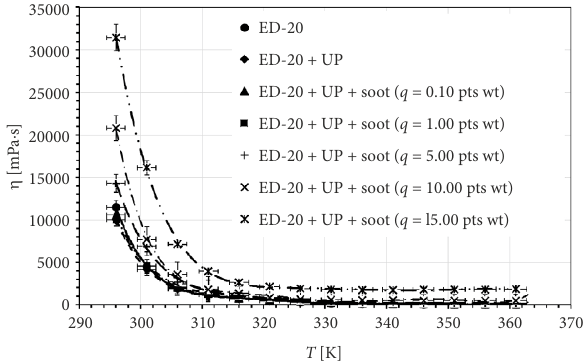
Figure 1. The effect of temperature T on the mean dynamic viscosity η of the sonicated and non-sonicated epoxy resin ED-20 and compositions with nanodispersed